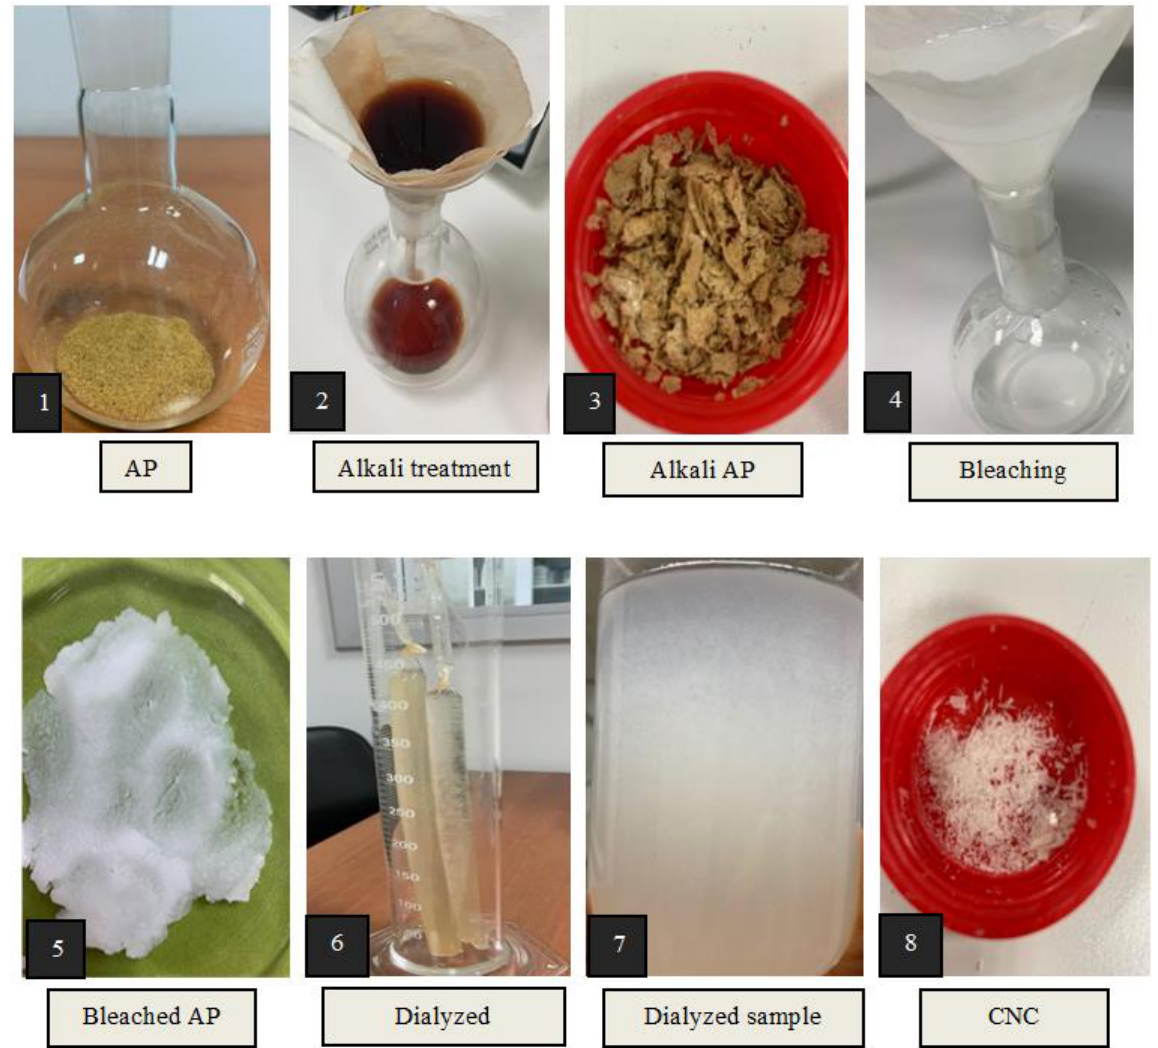
Figure 1. The steps for the extraction of cellulose and CNC from AP.